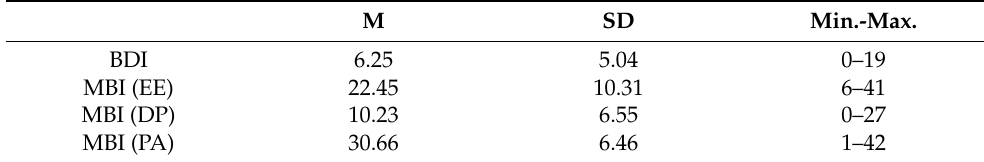
Table 2. Average scores for depressive symptoms and burnout ( n = 39).